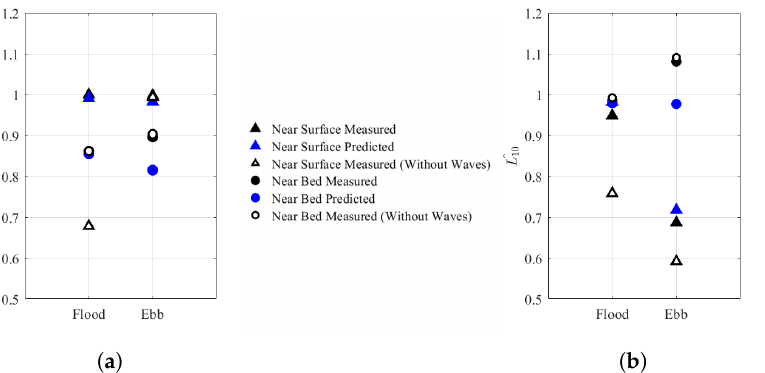
Figure 8. Normalised damage equivalent loads for each turbine position and location, calculated using the measured shear profiles and varying fluctuation intensity, with all samples and with wave cases removed. ( a ) Location A. ( b ) Location